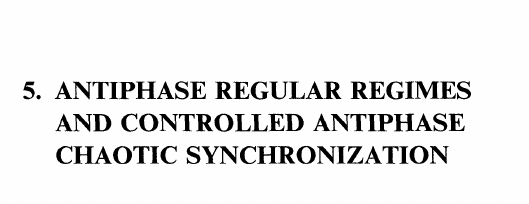
FIGURE 4 Basins of the chaotic attractor in the symmetric subspace (white color) and of the periodic orbit 2C (black color), a 3.5, -y 0.17.